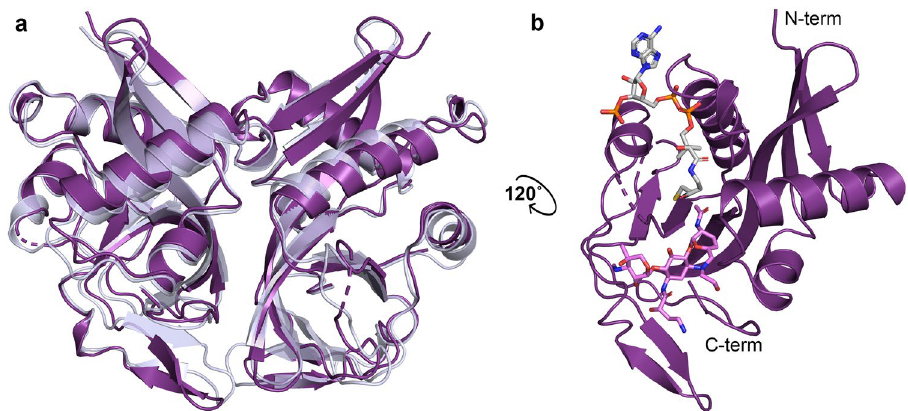
Figure 1. Structural features of AAC(2 ′ )-I enzymes. (a) Overlay of AAC(2 ′ )-Ia from P. stuartii colored in purple and AAC(2 ′ )-Ic from M. tuberculosis (PDB ID: 1M44) colored in pale blue. (b) Monomeric unit of AAC(2 ′ )-Ia highlighting N-terminus, C-terminus, and active site configuration, with acetylated plazomicin in violet and CoA in